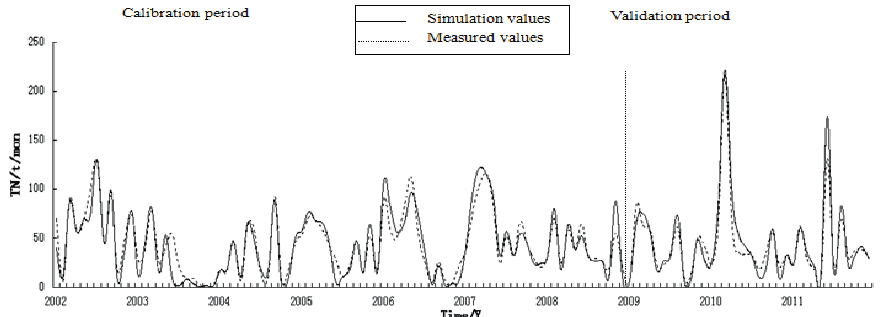
Fig. 3 Simulated and observed results of TN in calibration period and validation period.